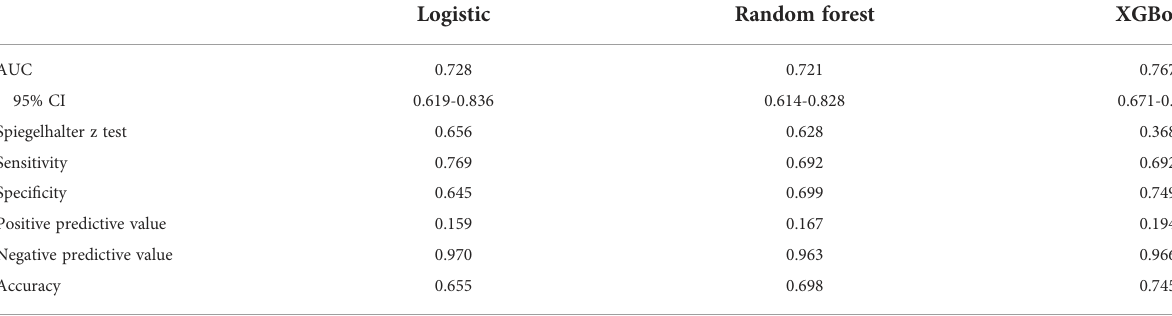
TABLE 3 Model performance of the logistic model, random forest model and XGBoost